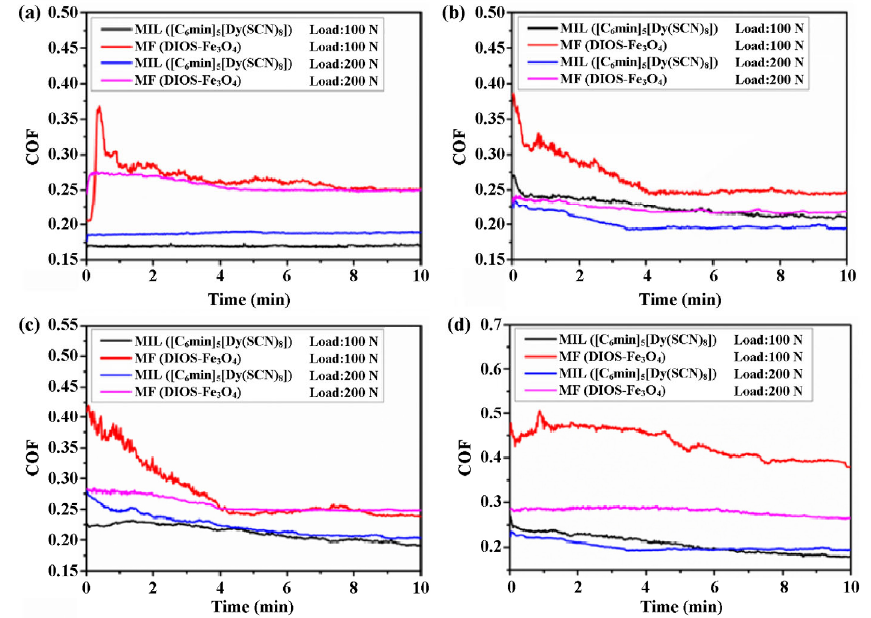
Fig. 8 Variation curves of friction with time: (a) 25, (b) 50, (c) 100, and (d) 150 °